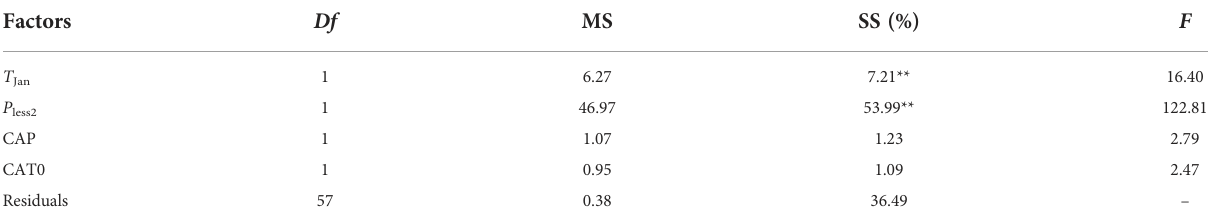
MS, meansquares; SS, proportion ofvariances explained bythe variable; T Jan , the average temperature in January; P less2 , precipitation oftheyears withless precipitation inthe past2 years; CAP, current accumulated precipitation from January 1 until the sampling day; CAT0, current accumulated temperature >0°C from January 1 until the sampling day. **p <